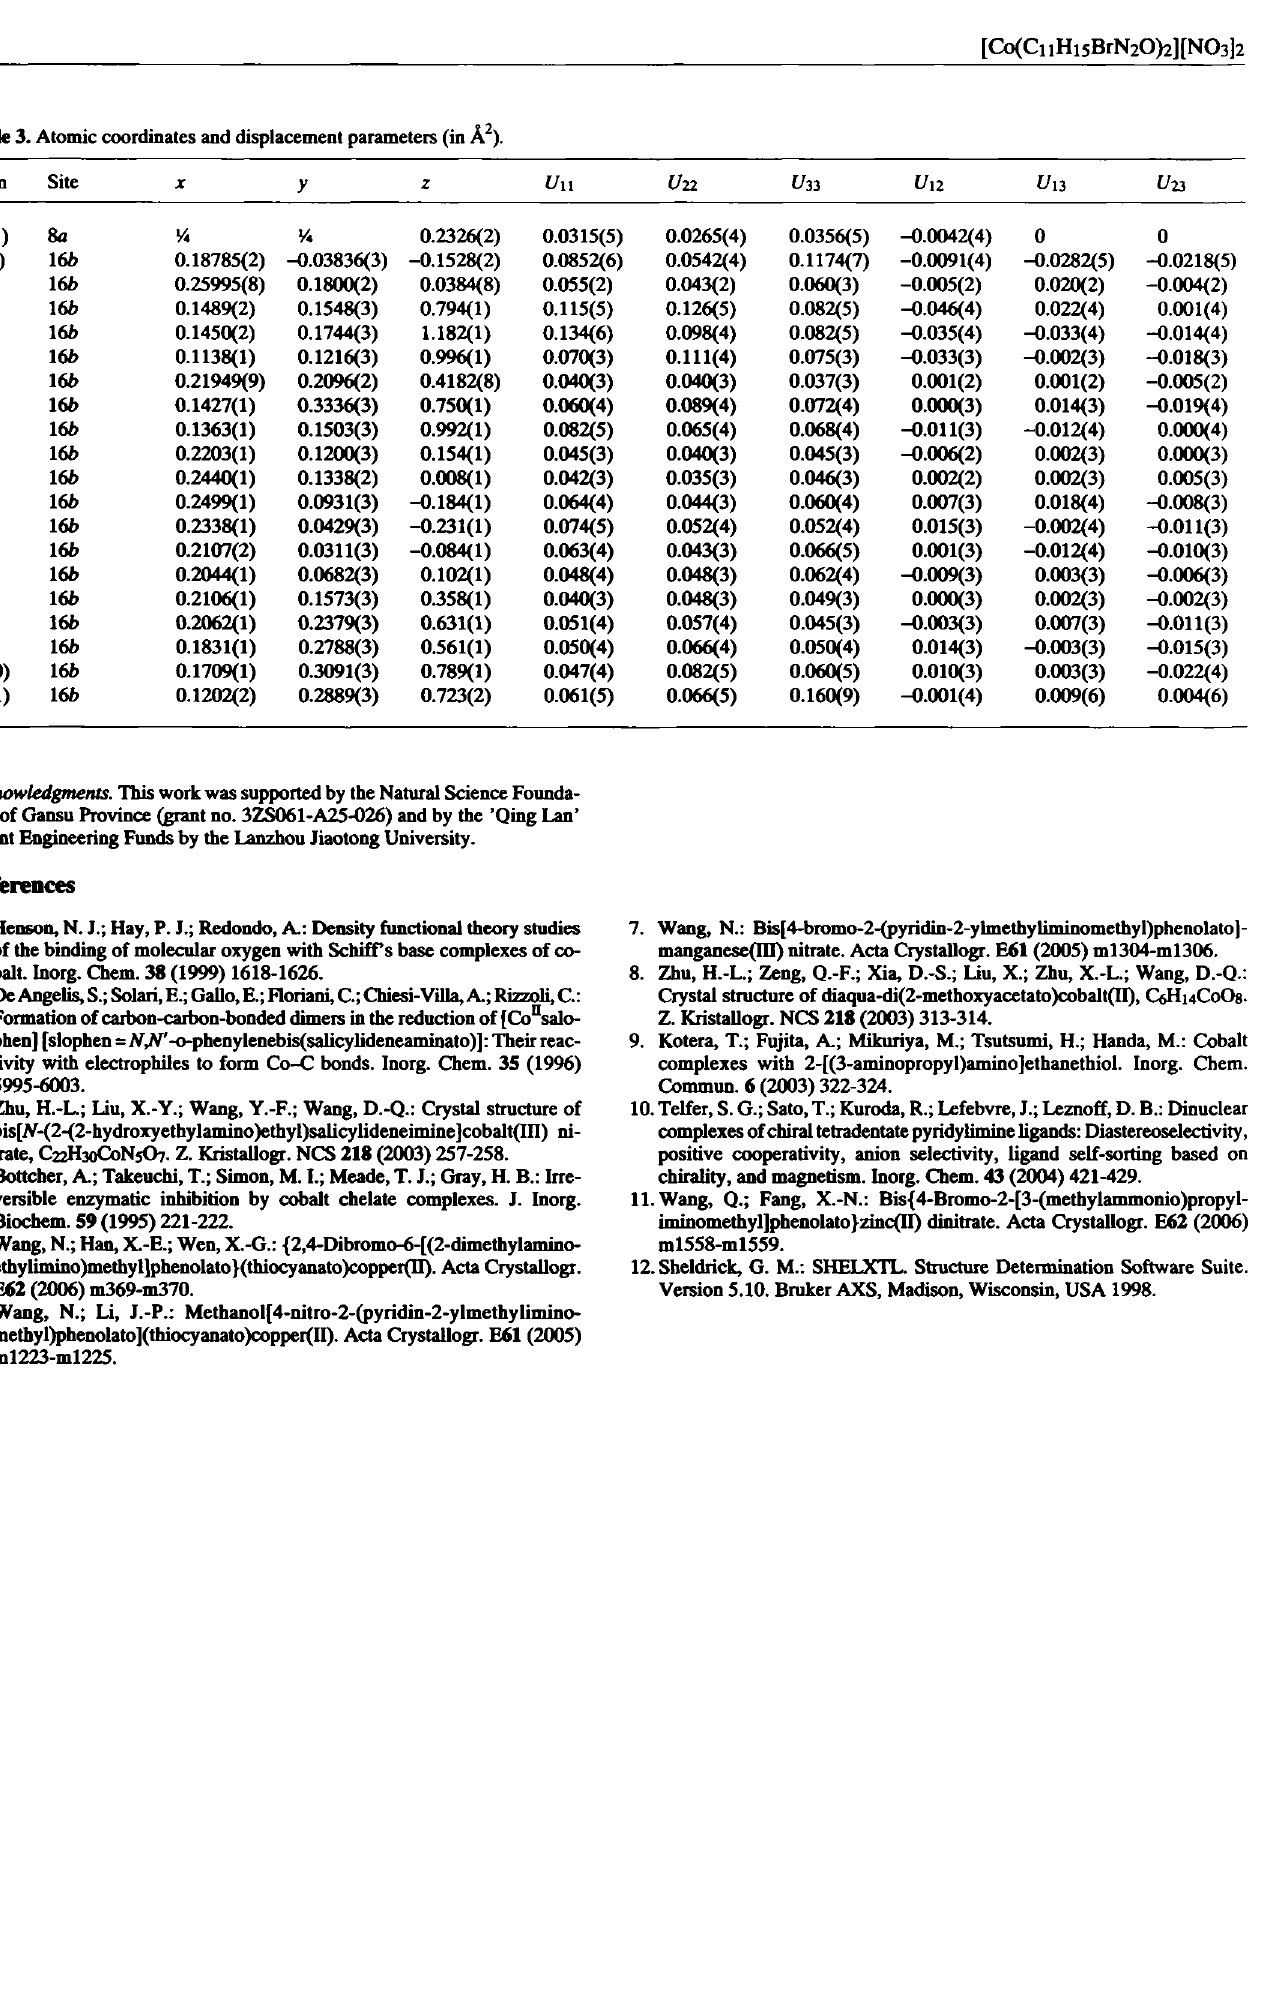
Table 3. Atomic coordinates and displacement parameters (in Ä 2